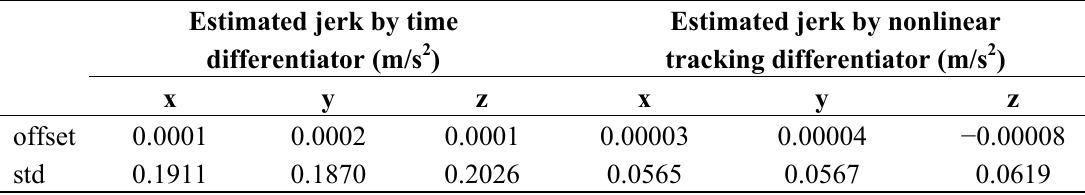
Table 1. Offset and noise standard deviation of estimated jerk in static condition with the two